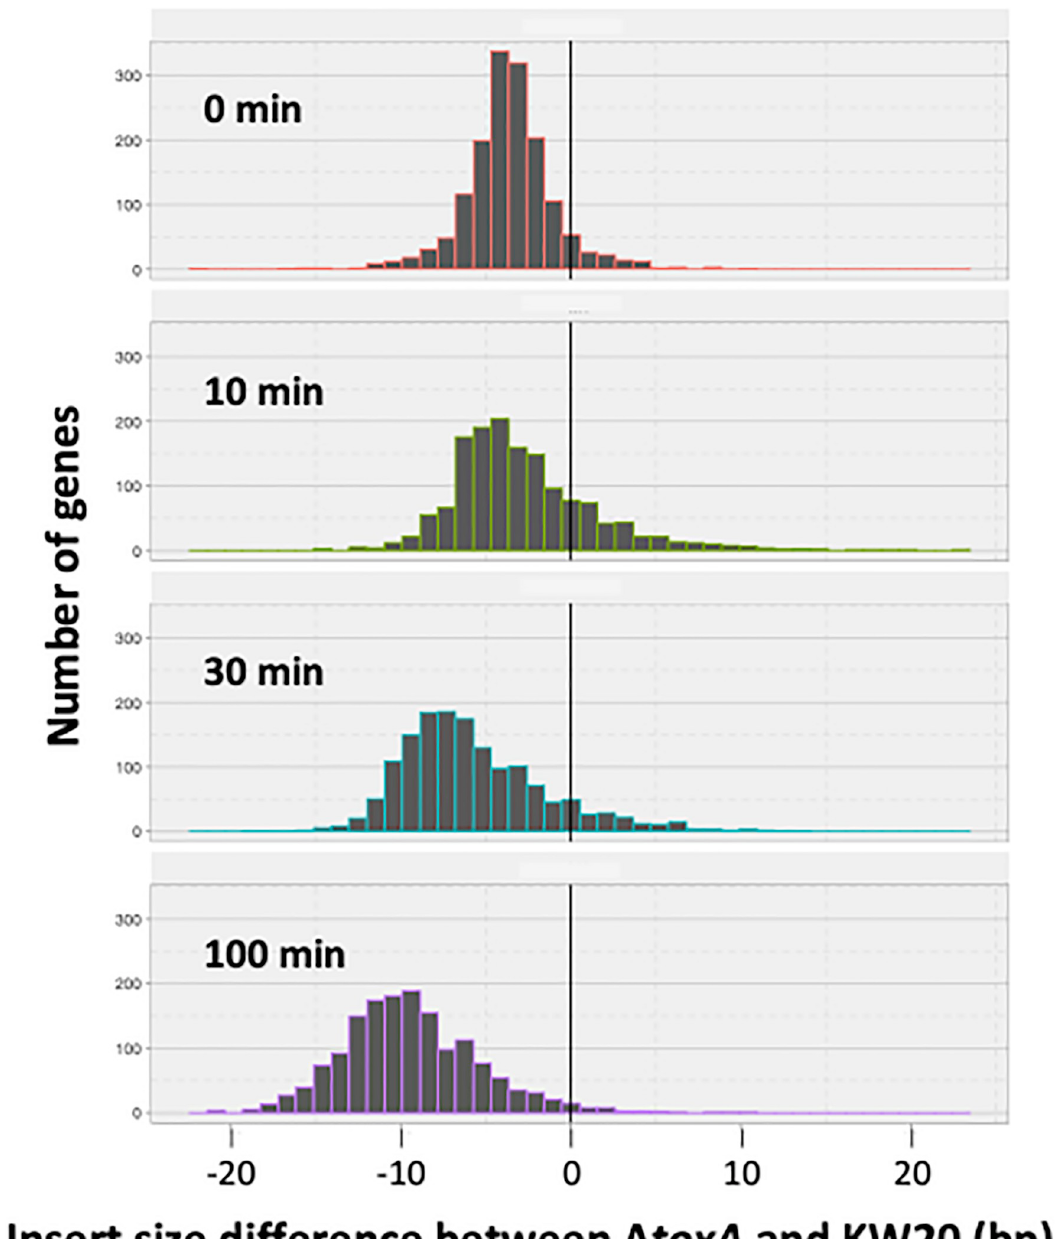
Fig 10. Distribution of insert-size differences between H . influenzae RNA-seq libraries prepared at the same time. Distribution of insert length differences between KW20 (kw20_A and kw20_B samples) and Δ toxA (antx_A samples) after 0, 10, 30 and 100 minutes in